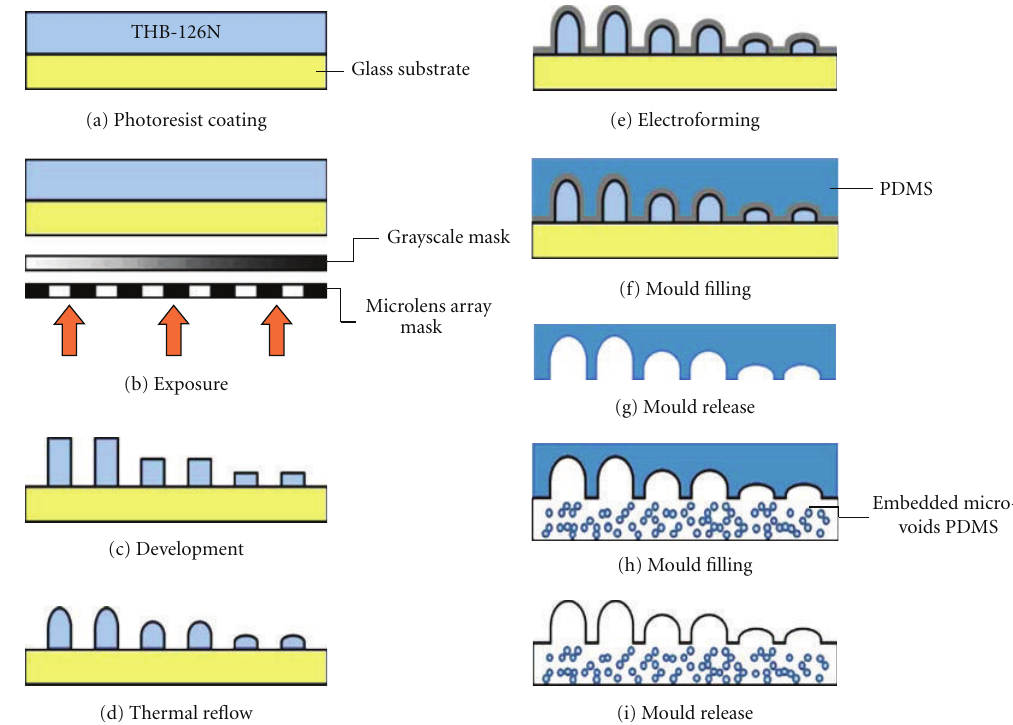
Figure 11: Manufacturing process of the embedded void optical compound film with gray scale microlens array.